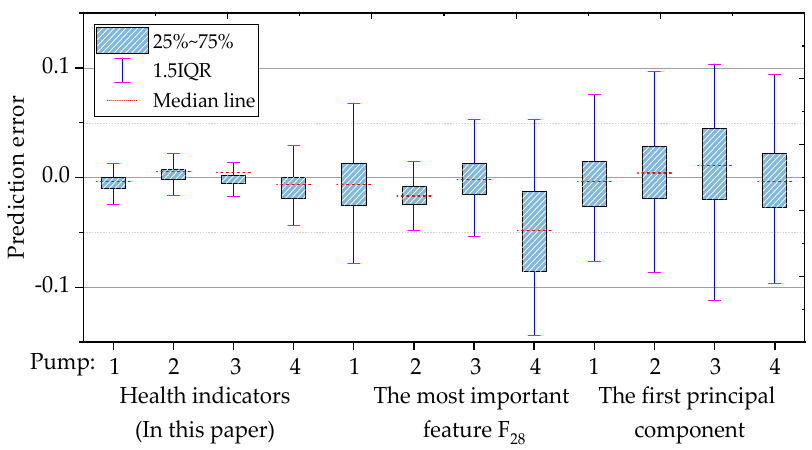
Figure 15. Box diagram of health indicator prediction deviation of four gear pumps.